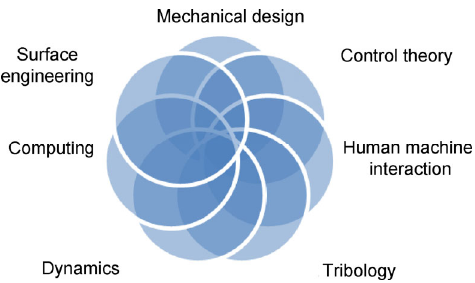
Fig. 1 The area of manipulator design modelling and control arises from the confluence of several branches of engineering and science.